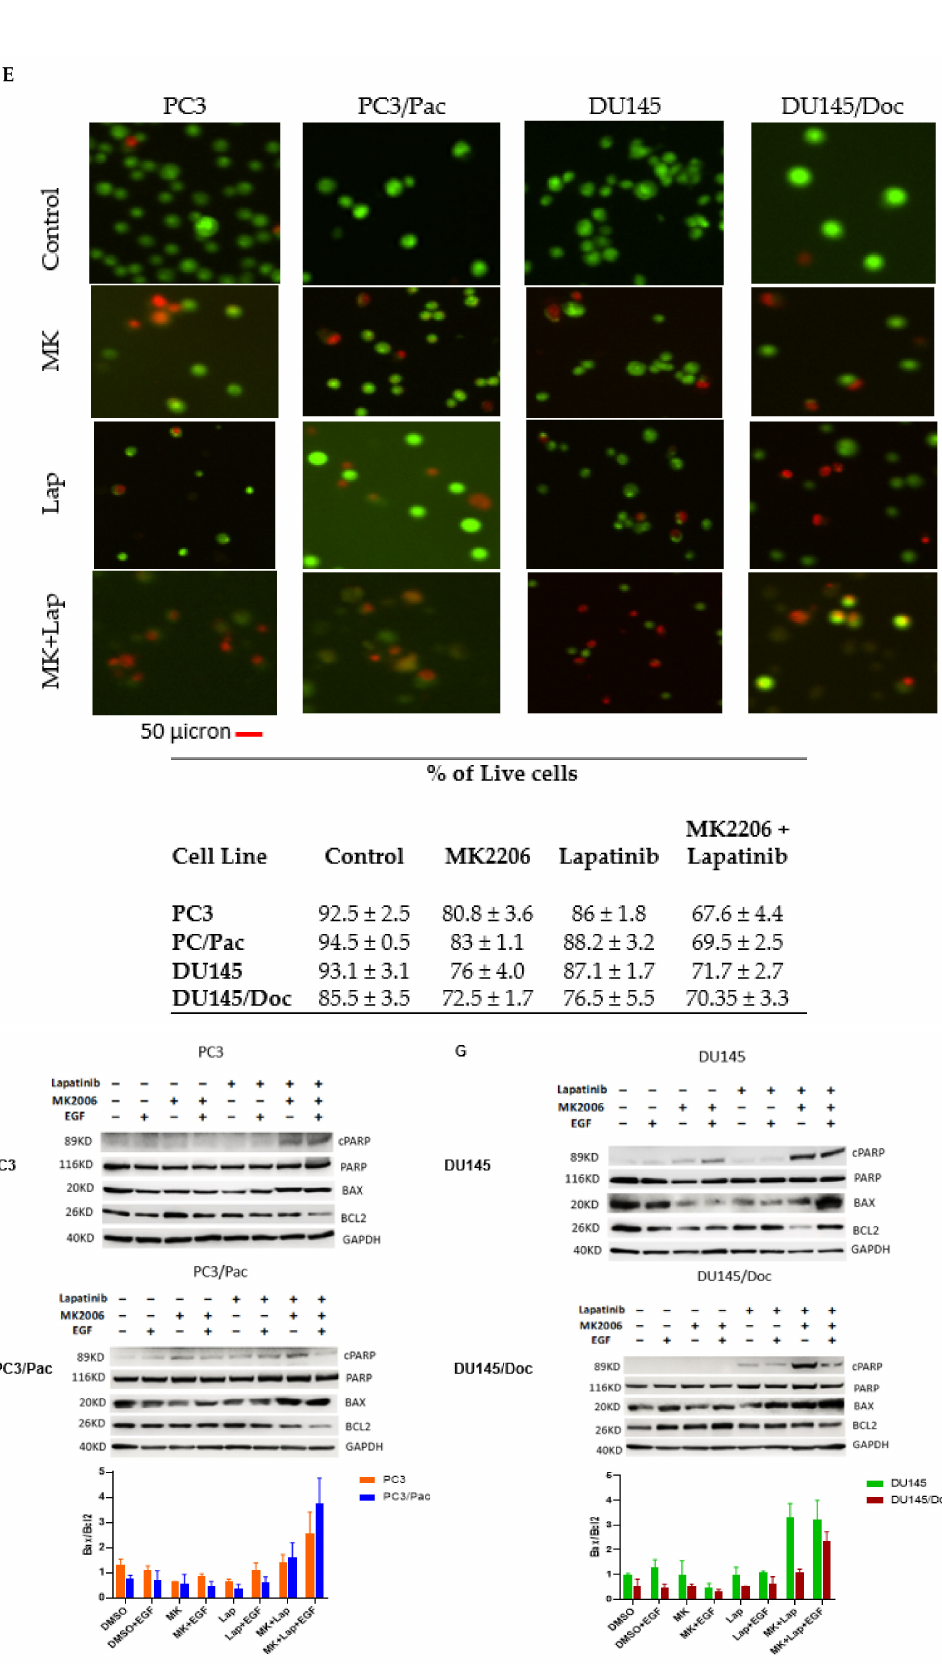
Figure 3. Effects of ErbB and AKT targeting on cell proliferation and cell death. The doses of the inhibitors that were used for all experiments, either singly or in combination, were lapatinib 3 µ M for all four cell lines, 6 µ M MK2206 for PC3, PC3/Pac and 15 µ M MK2206 for DU145,